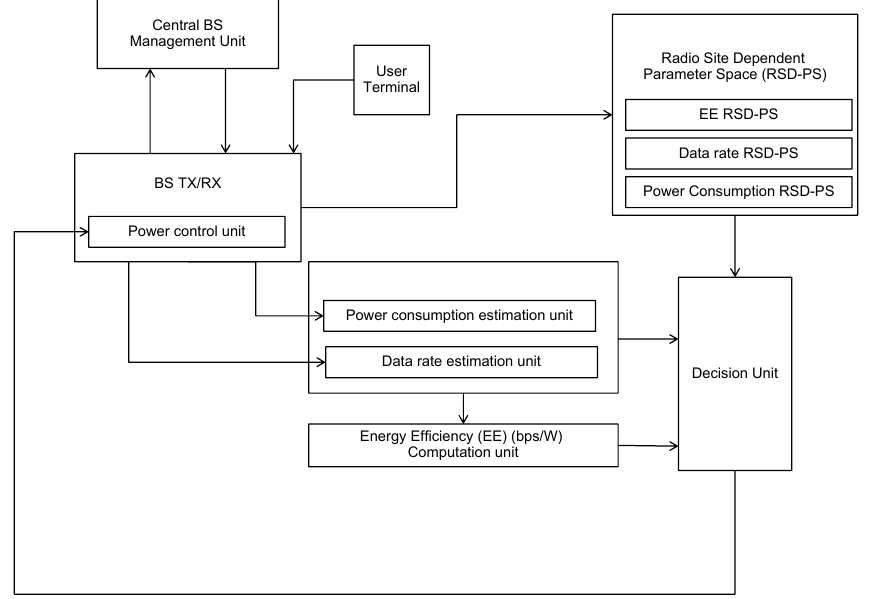
Figure 5. Block diagram of the proposed BS